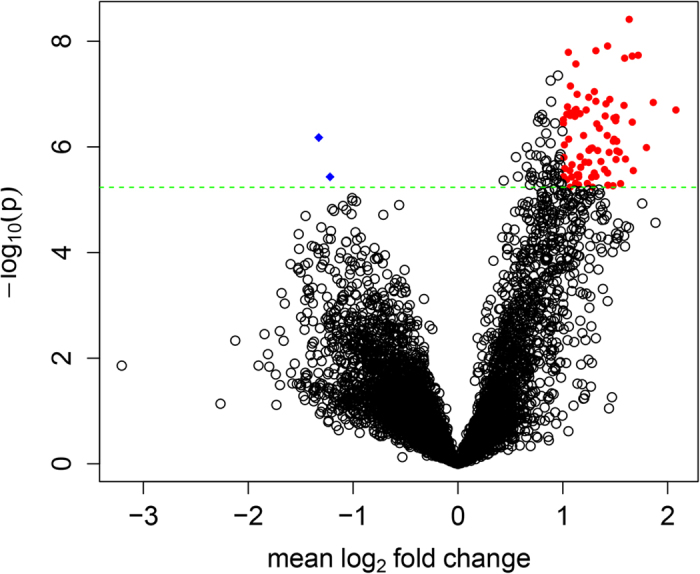
Volcano plot of mRNA expressions.Plotted along the x-axis is the mean of log2 fold-change, along the y-axis the negative logarithm of the p-values. Red denotes the 82 up-regulated genes, blue the 2 down-regulated genes. The horizontal green line is the negative logarithm the Bonferroni-adjusted P-value threshold (5.82E-6).